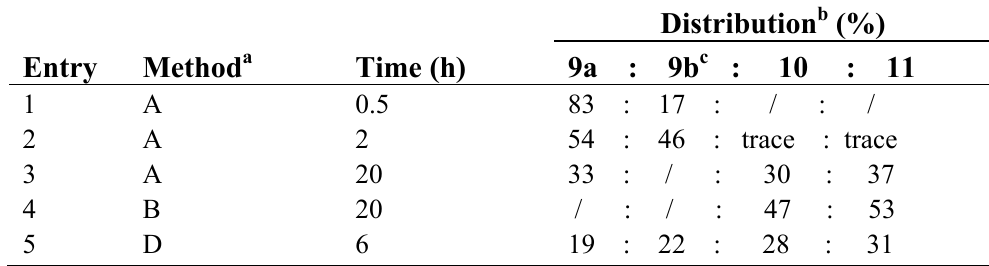
Table 2. Chlorination of 2,4-dimethyliodobenzene ( 9a